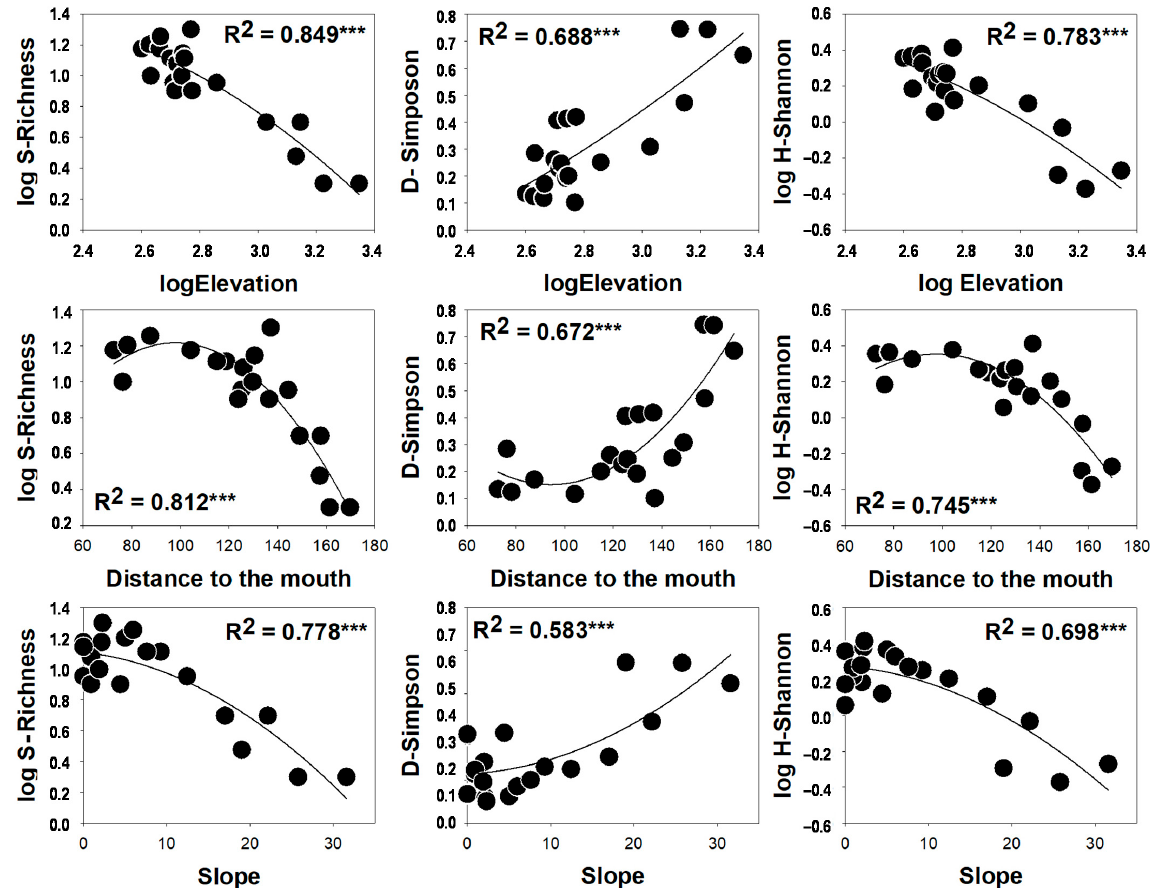
Figure 2. Estimates of the fish community diversity indices along the Alto Madre de Dios River, regarding to elevation, distance to the mouth and slope of sampling points. *** significative coefficient of determination (R 2 ). Table 2. Relative abundance of taxa presents under (U) and above (A) 700 m of elevation.